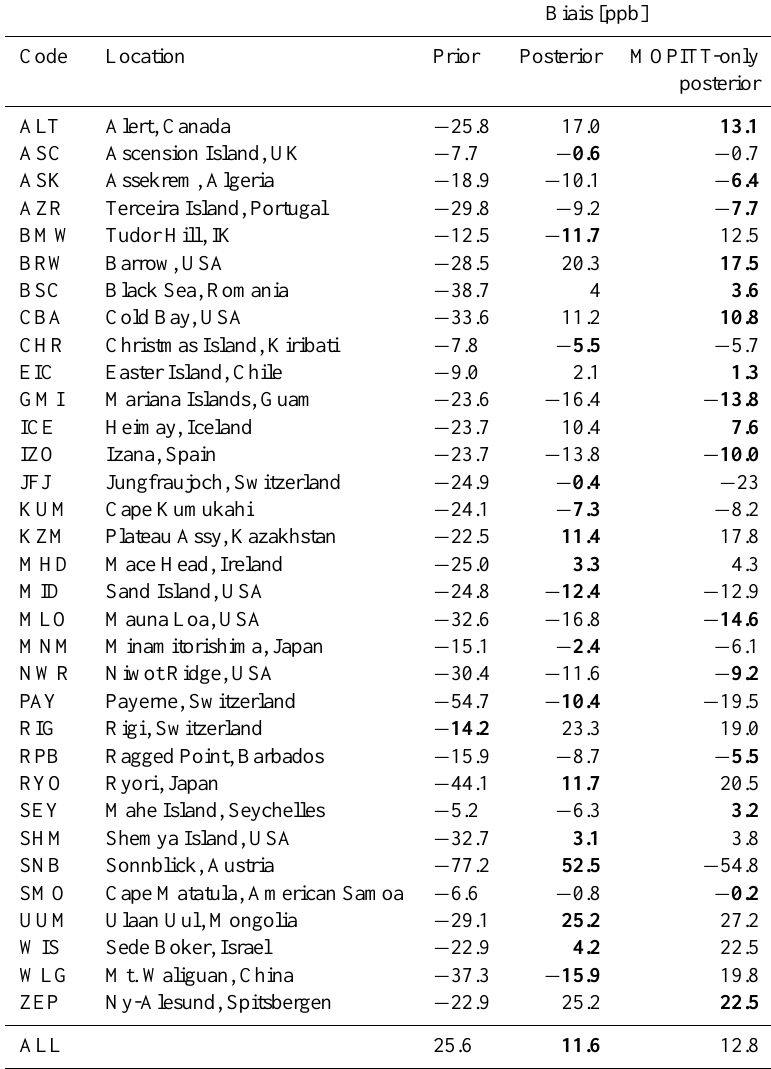
Table 3. Statistics of the fit for the 33 stations chosen in the Northern Hemisphere. Bias is defined as the mean difference between observed and modeled CO concentrations (model-minus-observation, average over the year 2006). The “MOPITT-only posterior” bias is given by Fortems-Cheiney et al. (2011). The lowest bias for each station is highlighted in bold.